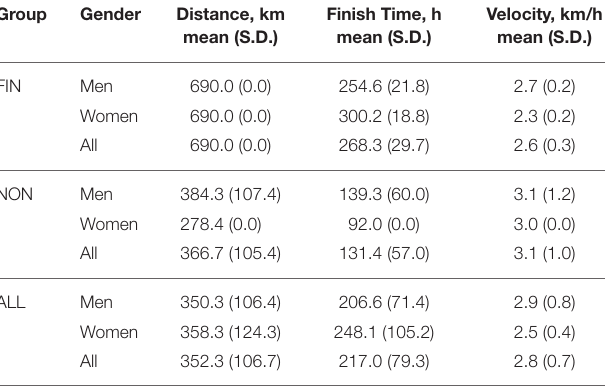
Group Gender Distance, km